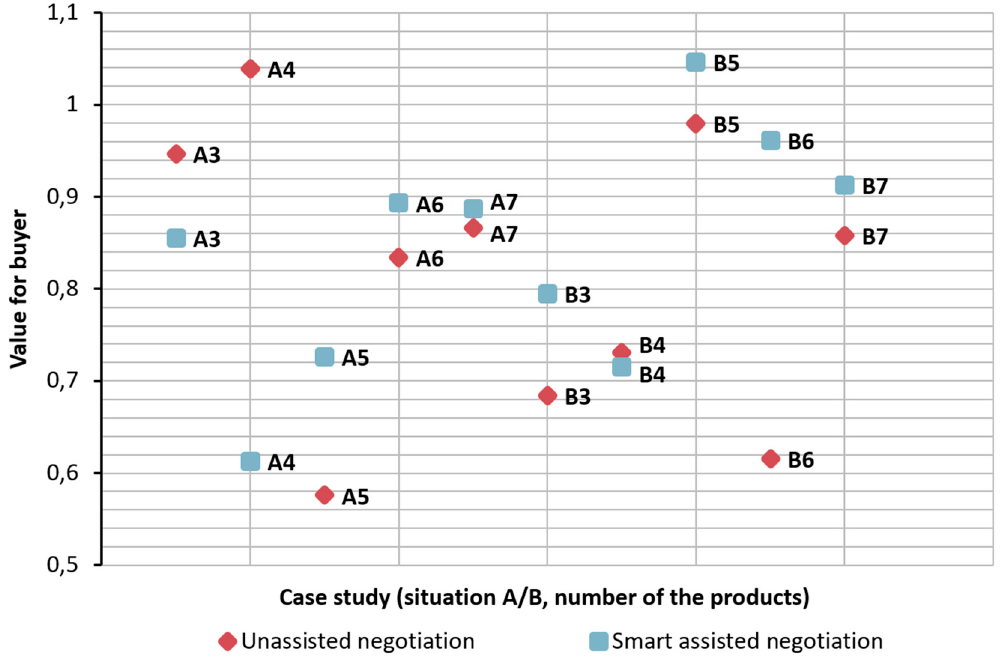
Figure 3. The ratio of costs and benefits for the buyer.